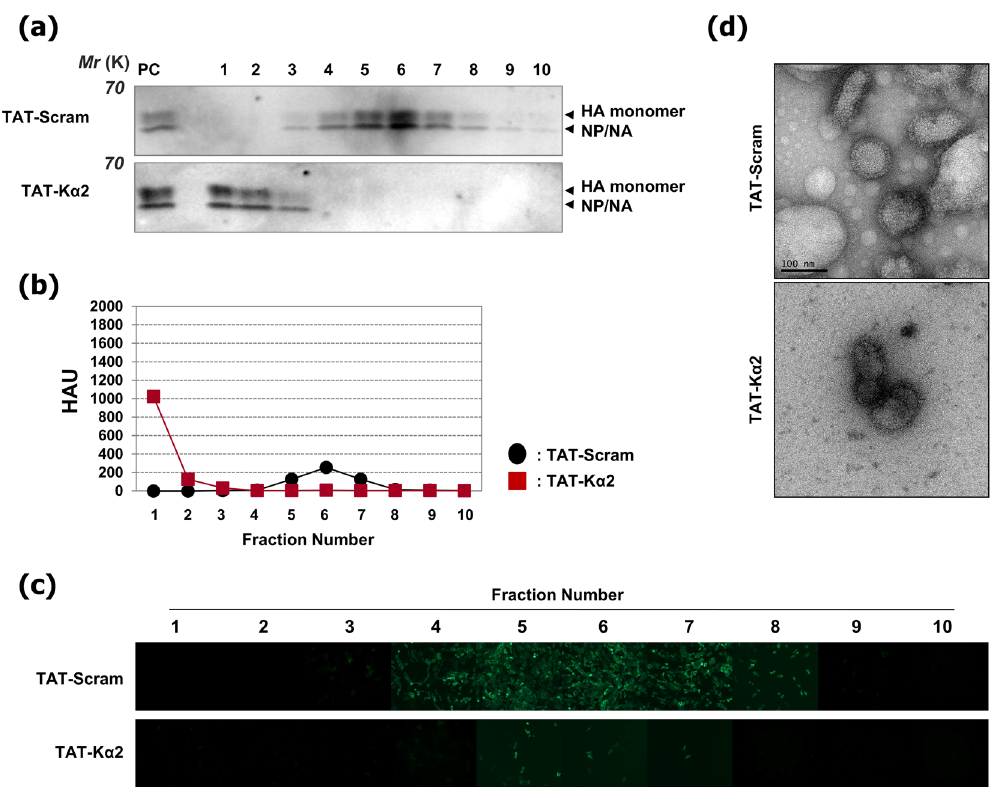
Figure 2. Velocity sedimentation ultracentrifugation. We investigated the biophysical properties of the PR8- GFP virus that had been treated with TAT-K α 2 peptide using the velocity sedimentation ultracentrifugation method to determine the virucidal mechanism of the TAT-K α 2 peptide. The virus was pre-incubated with the peptide (TAT-K α 2 or TAT-scramble) and loaded onto a continuous gradient, and fractions were collected as described above. ( a ) Immunoblotting of each fraction derived from a mouse that survived the PR8 challenge test with a polyclonal antibody. HA, NA, and NP proteins of the PR8 virus were detected. PC: wild-type PR8 virus was loaded. ( b ) Two-fold serially diluted fractions were tested for hemagglutination. ( c ) MDCK cells were infected with each fraction to compare the infectivity of PR8-GFP viruses that were treated with each peptide. ( d ) Morphological differences in the virus particles between TAT-K α 2-treated virus and TAT-scramble peptide- treated virus were observed by TEM. Bar, 100 TAT-K α 2 peptide shows virucidal activity in vivo . Mice were simultaneously intranasally inoculated with 12 μ M of TAT-K α 2 peptide and 10 MLD 50 (50% of the mouse lethal dose) of the highly pathogenic avian influenza virus A/EM/Korea/W149/06 (W149, HPAI, H5N1) and were monitored for 15 days. Significantly dif- ferent body weight percentages were observed among the groups from 5 days post-infection (DPI), and the dif- ferences were increased by more than 20% from 8 DPI (Fig. 3a). Moreover, the survival rate of the TAT-K α 2 peptide-treated mice was 100%, whereas none of the TAT-scramble peptide-treated mice survived on 9 DPI (Fig. 3b). At 3 and 5 DPI, three mice in each group were sacrificed for virus titration in the lungs. Mice that were treated with virus alone or virus with the TAT-scramble peptide contained very high titers of the W149 virus, and there was no significant difference between these groups. However, no virus was detected in the TAT-K α 2 peptide-treated group (Fig. 3c). Additionally, three mice in each group were sacrificed for histopathological